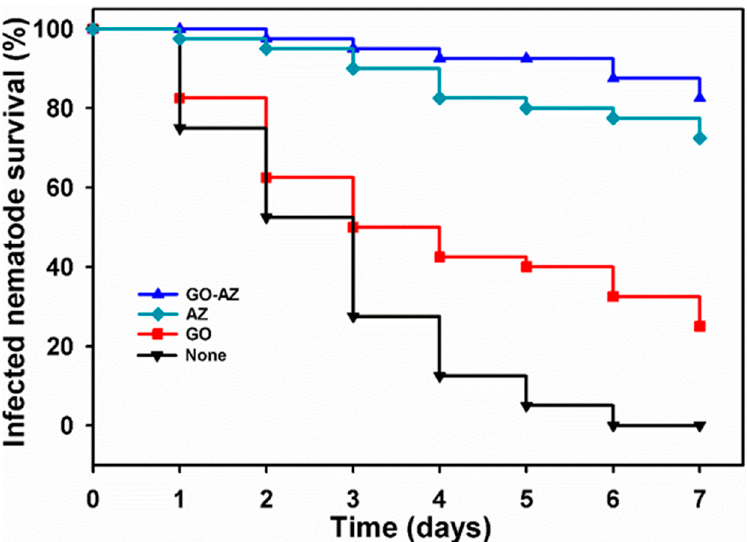
Figure 4. Kaplan–Meier survival curves of C. albicans -infected nematodes: Results representing the survivability of C. elegans with GO, AZ, and GO-AZ at 10 µg/mL. Nematodes without a sample treatment were considered as none. The percentage survivability exhibit the results of three independent experiments (n = 60) performed.